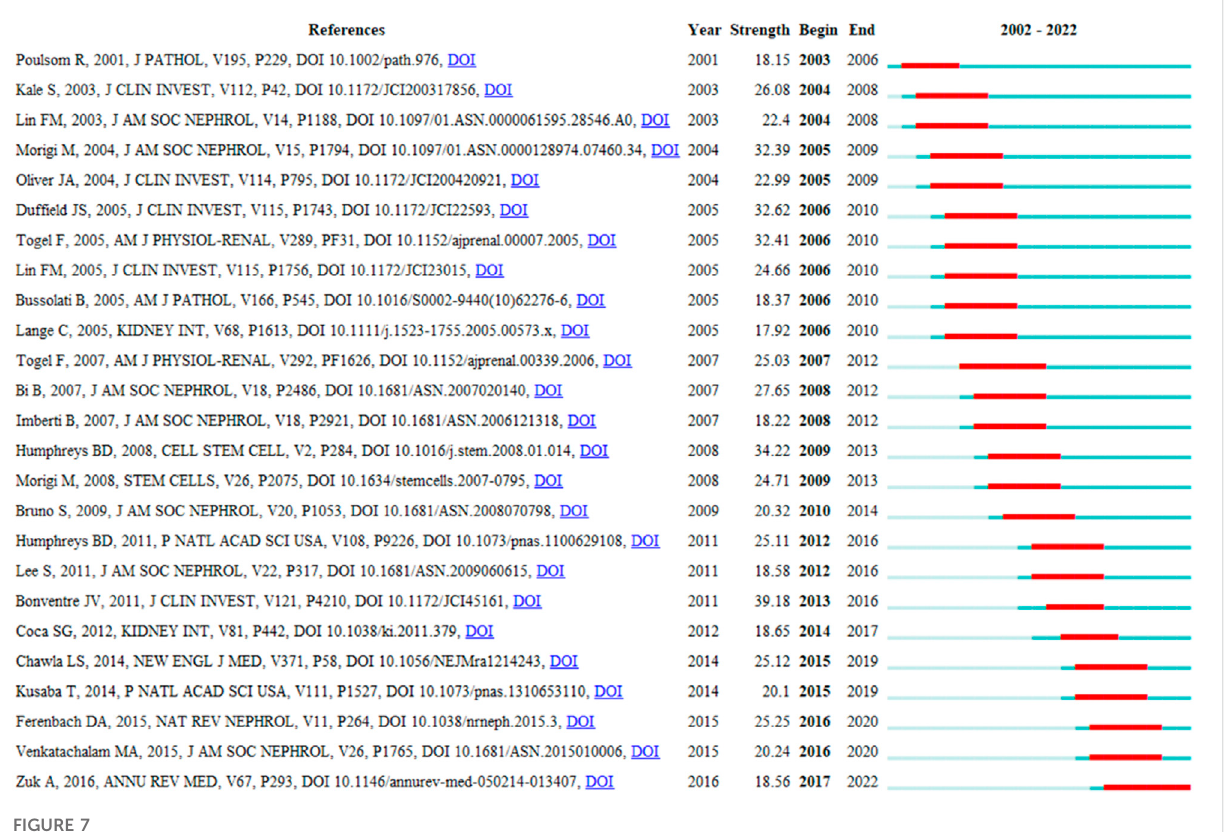
FIGURE 7 The top 25 references with the strongest citation bursts during 2002 –